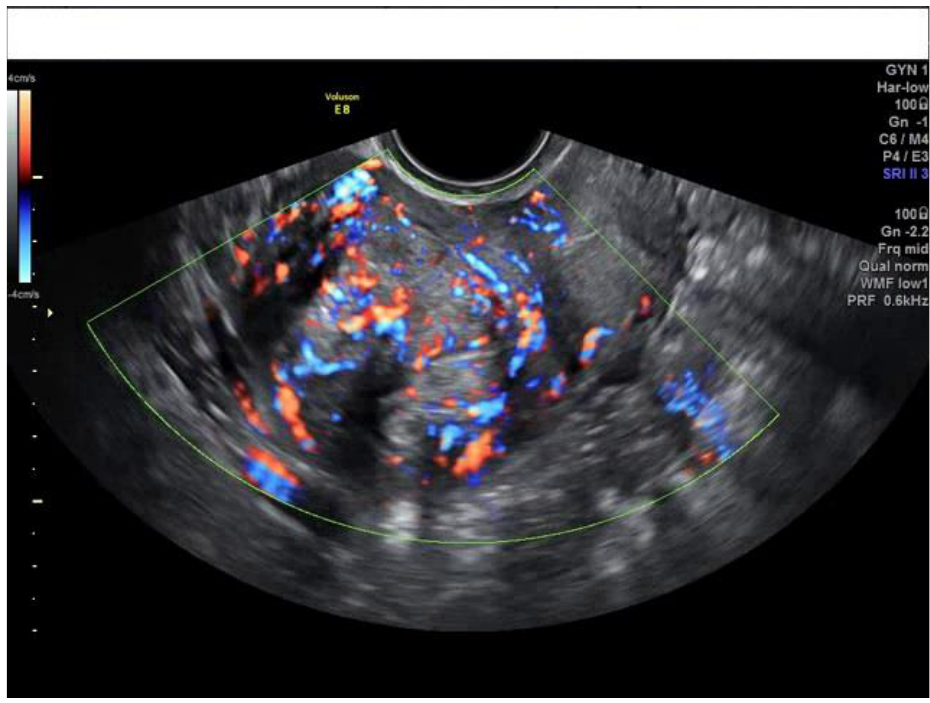
Figure 3. Transvaginal ultrasound of a myoma with an intralesional vascular score of 4.